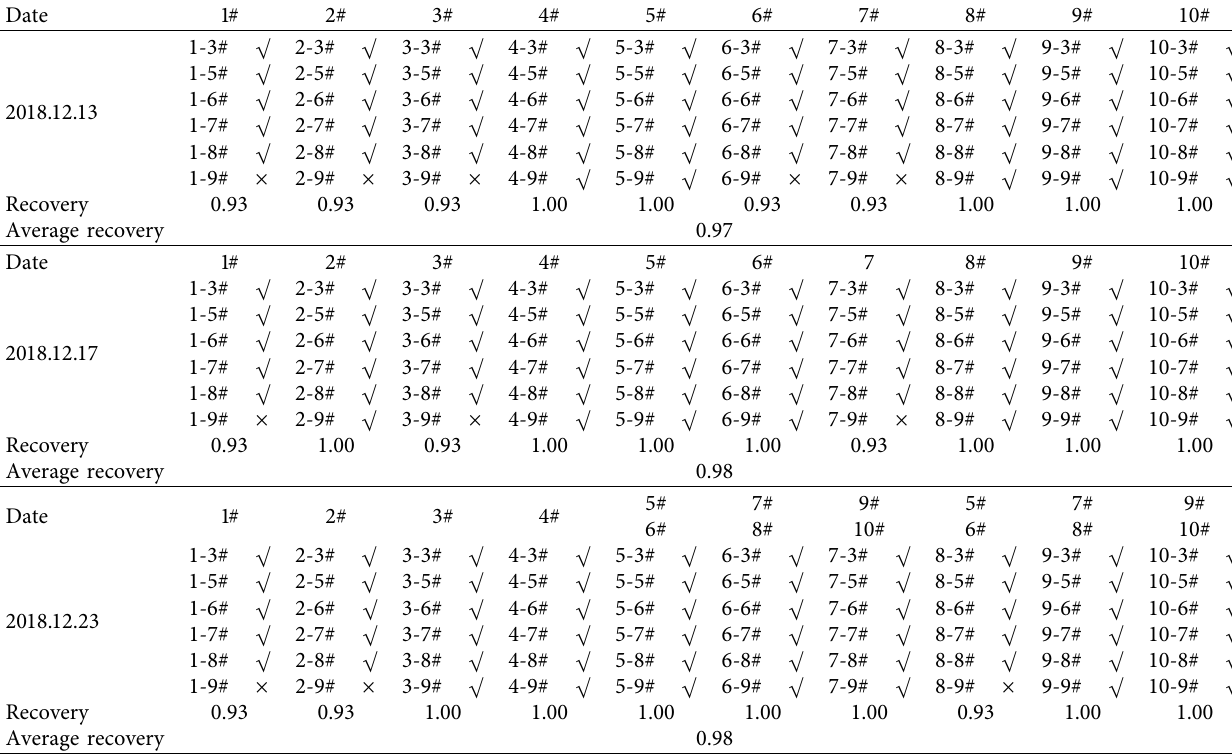
Table 7: Monitoring data of top coal recovery under the condition of one cutting and one caving with multicycle-sequence coal caving (“ √ ” means the monitoring point has been recovered, “ × ” means the monitoring point has not been recovered).